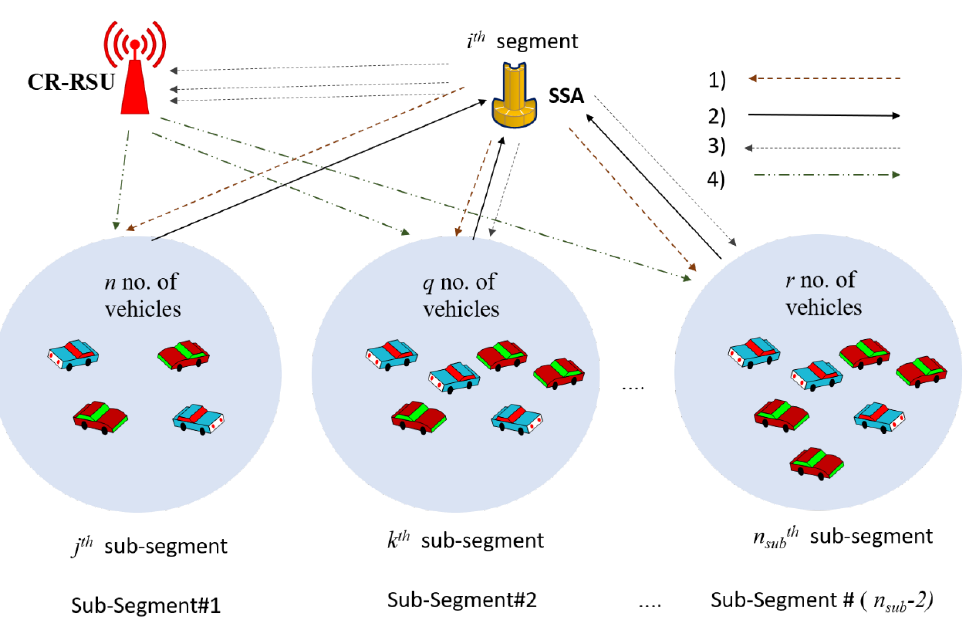
Figure 3. Sub-segmented cooperative spectrum sensing (CSS).